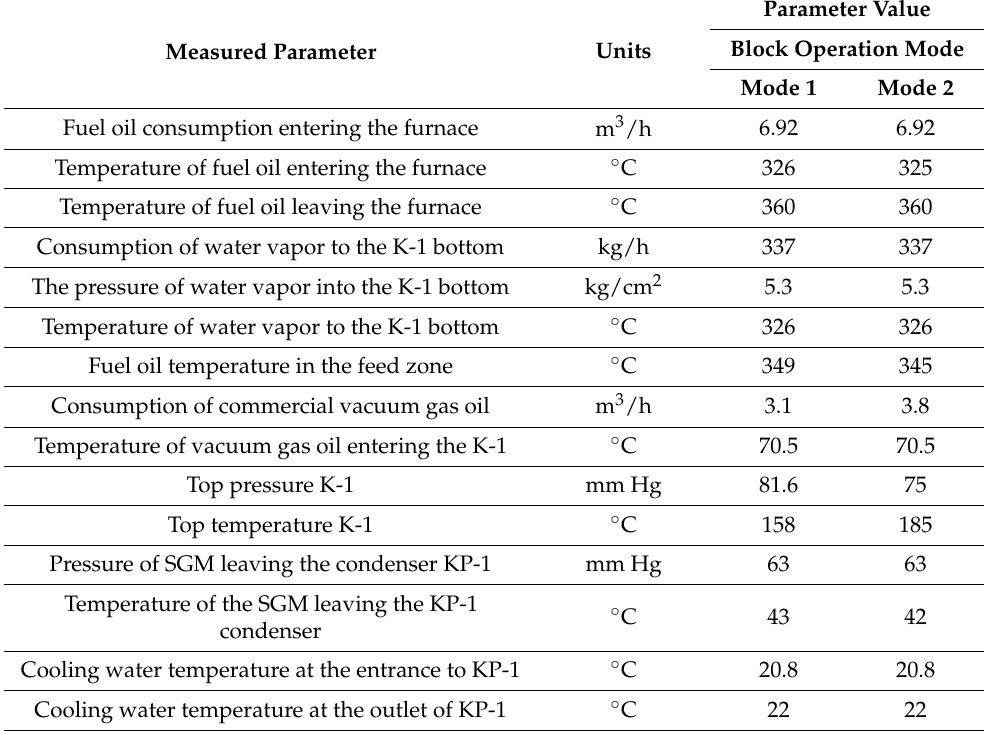
Table 7. Technological parameters of the installation.